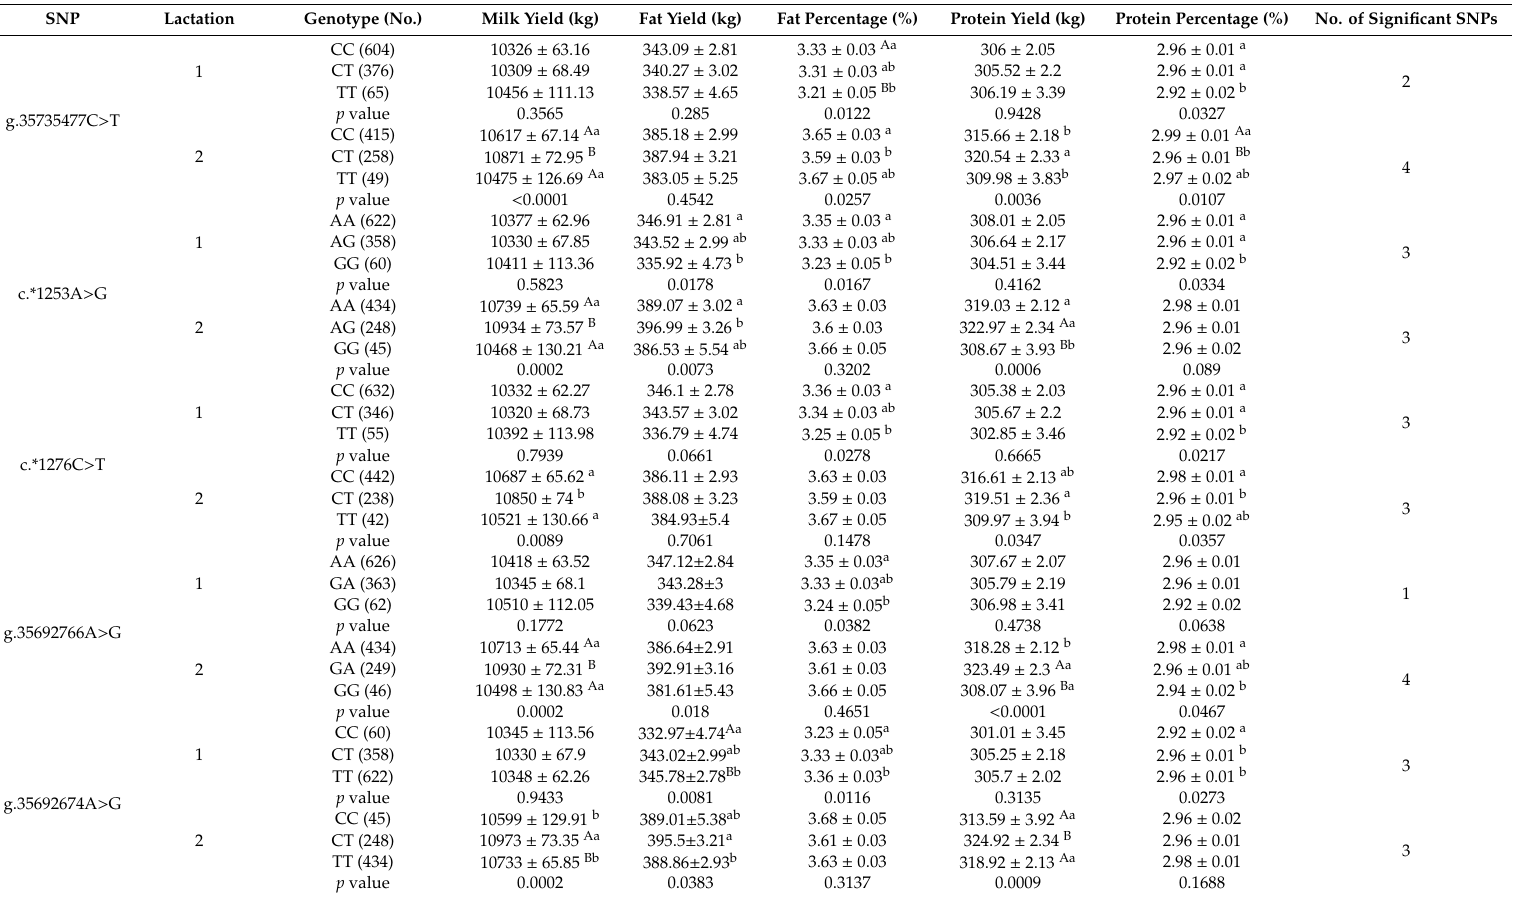
Table 2. Associations of ten SNPs of NUCB2 gene with milk production traits in two lactations in Chinese Holstein (LSM ±